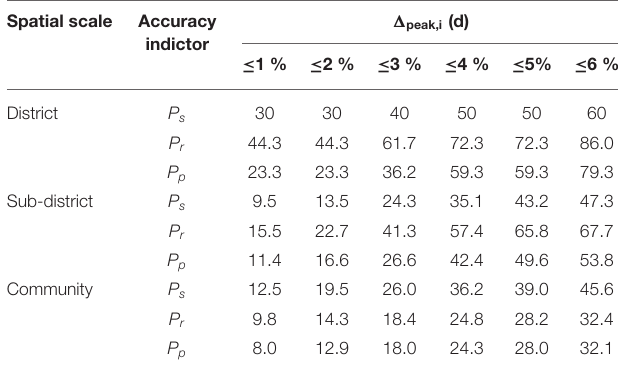
intra-urban scales. Spatial scale Accuracy